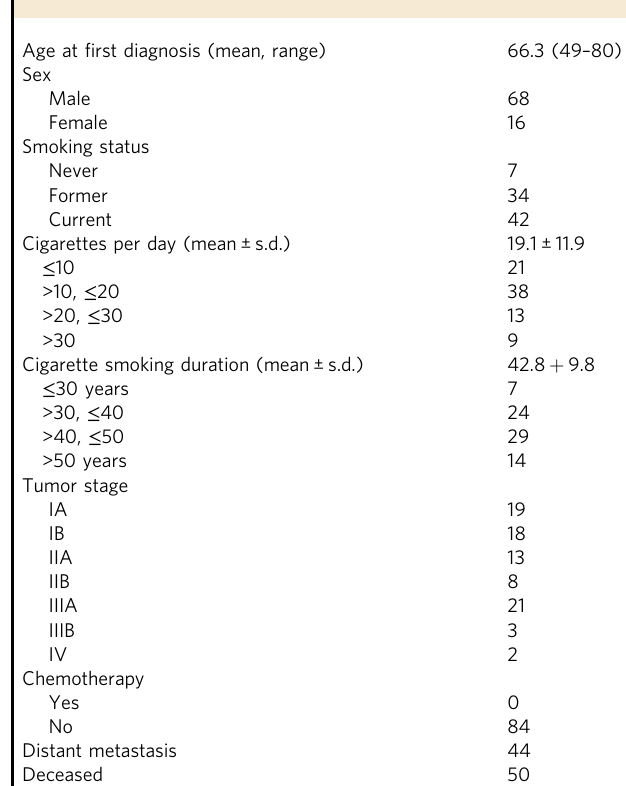
Table 1 Distribution of demographic and clinical variables of 84 patients with lung